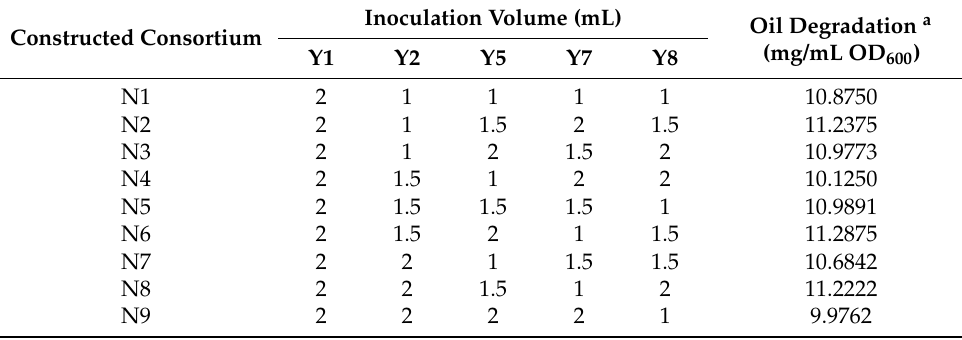
Table 4. Optimization of petroleum-degrading